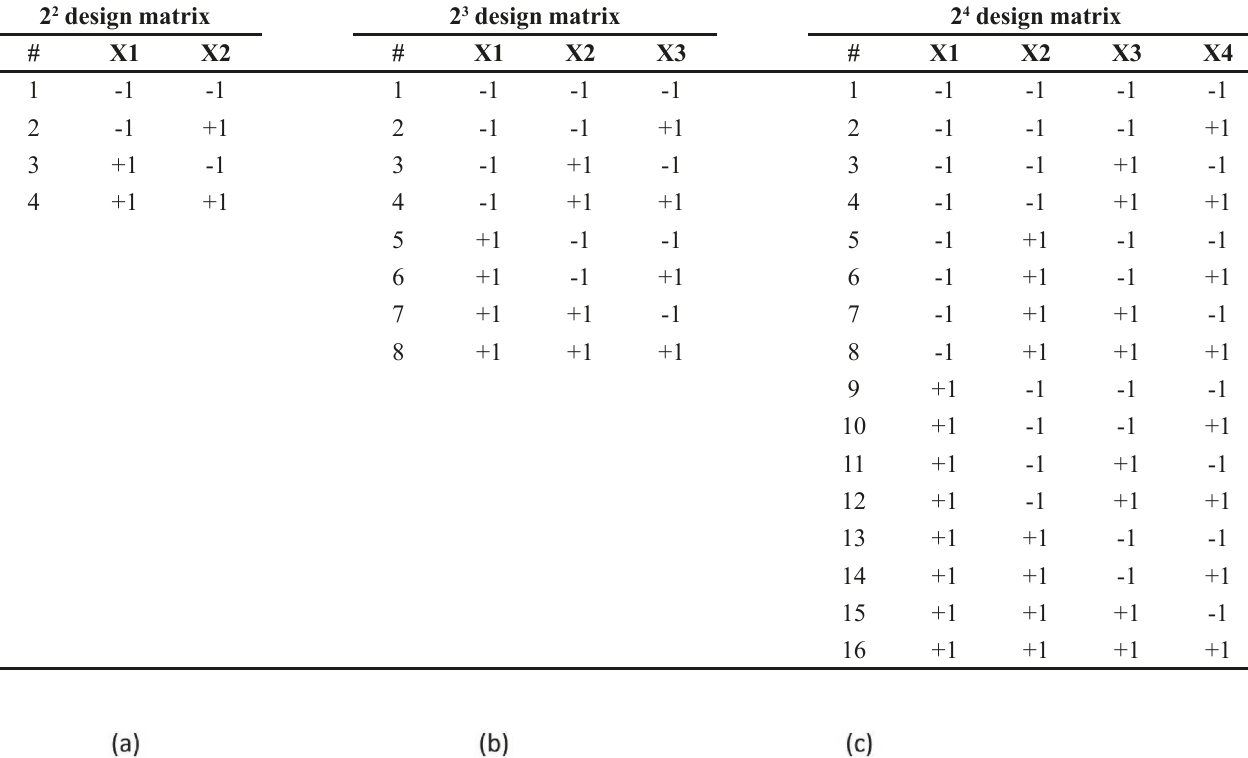
TABLE II – Two-level full factorial designs matrix for two (2 2 ), three (2 3 ), and four (2 4 ) input factors (X1 to X4)